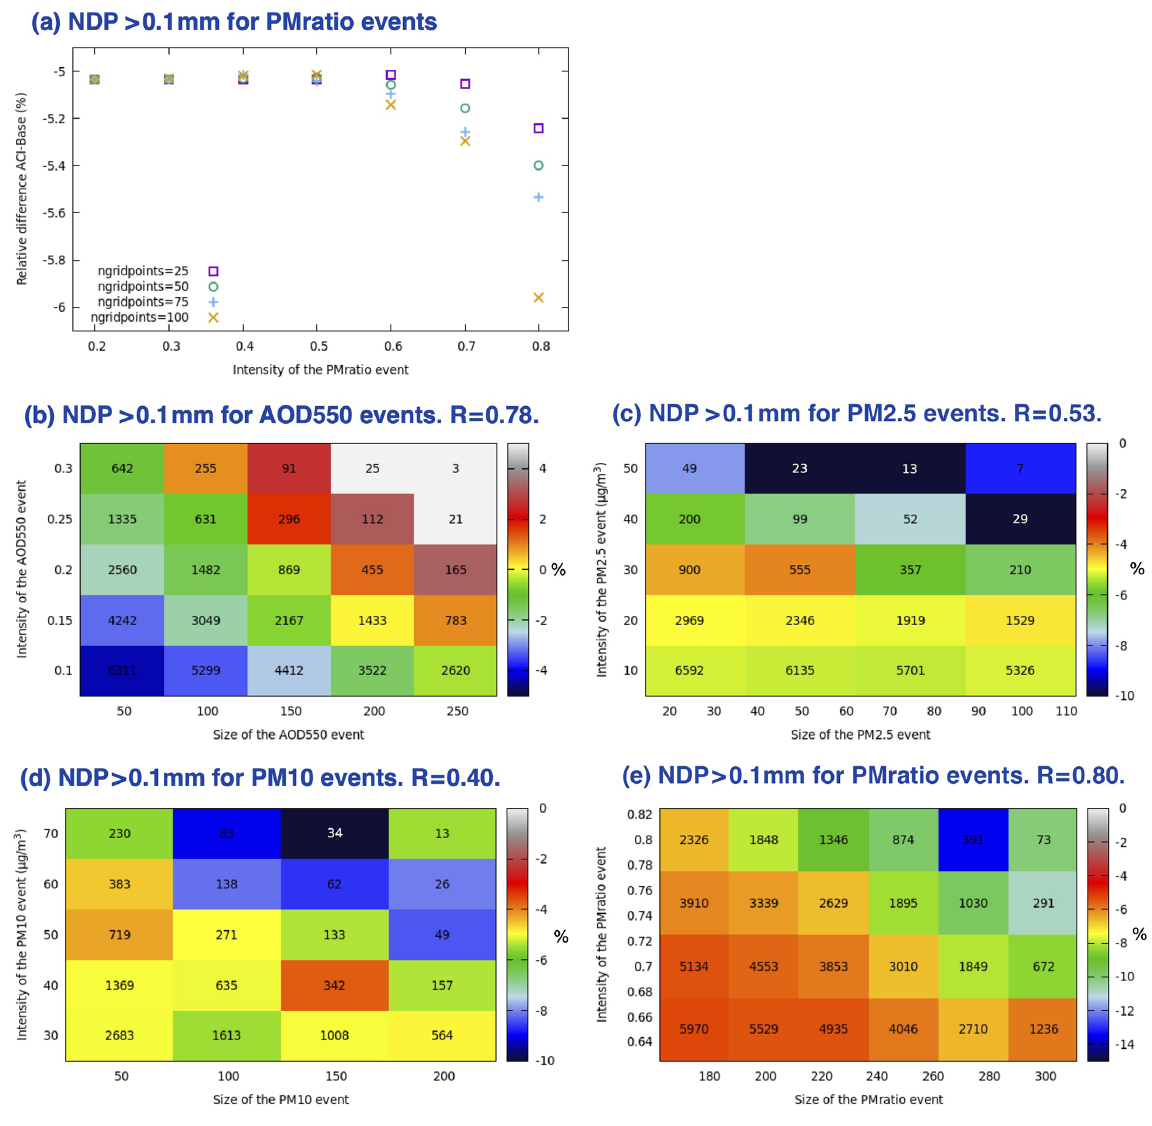
Figure 5. Relative difference (colors) in the ARCI–BASE simulations for the 1991–2010 period based on (b) the intensity and size of AOD550 events, (c) the intensity and size of PM 2 . 5 events, (d) for events of PM 10 , and (e) for those of PM ratio . The calculation is made for the domain cells with significant ARCI–BASE differences for the number of days with precipitation > 0.1mm (Fig. 2b) and only for the zone where the non-linear behavior begins ( > 0 . 6) in (a) (identical to the other variables). The number inside the boxes indicates the number of days meeting the corresponding criteria of intensity and extent of events. R denotes the multiple regression coefficient resulting from a multi-linear adjustment of those